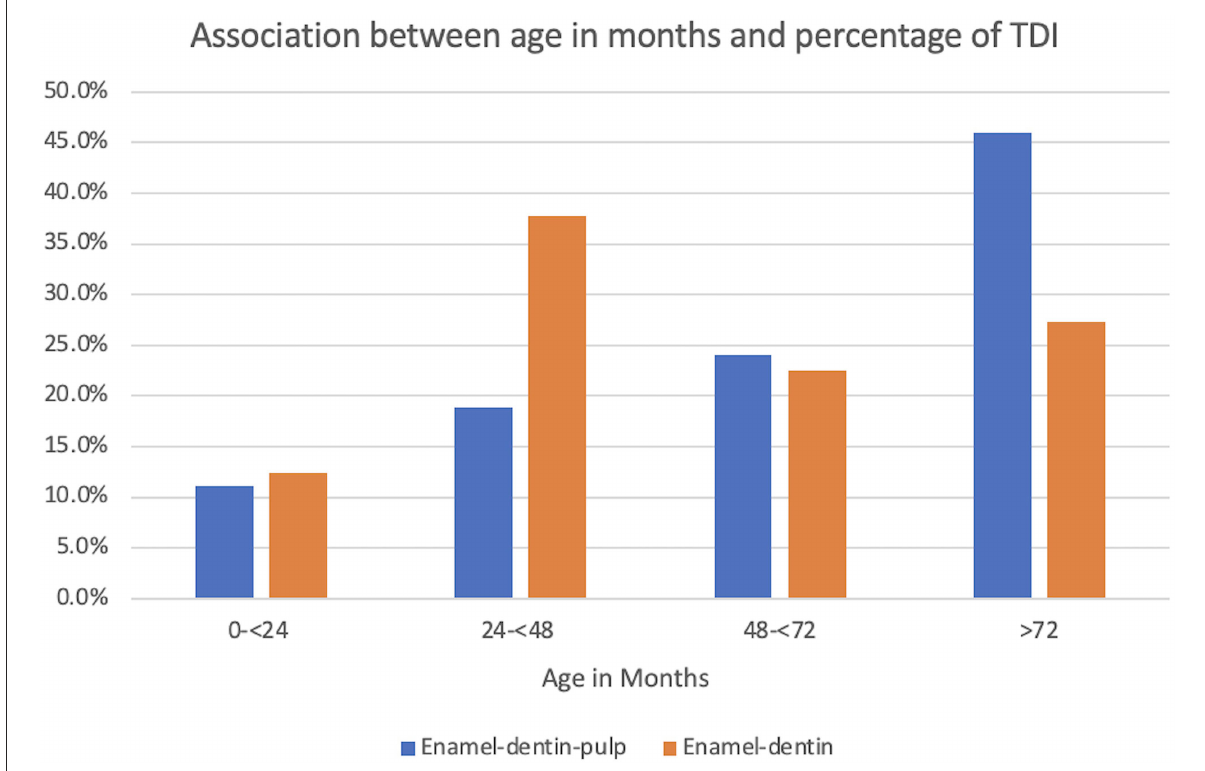
canine tooth, the left maxillary canine tooth, the right maxillary second incisor tooth, and the left mandibular canine tooth. In this study, enamel-dentin fractures accounted for 40.1% of all TDIs. The teeth most affected by enamel-dentin fractures were the canine teeth (29.4%) and the incisor teeth (28.3%).